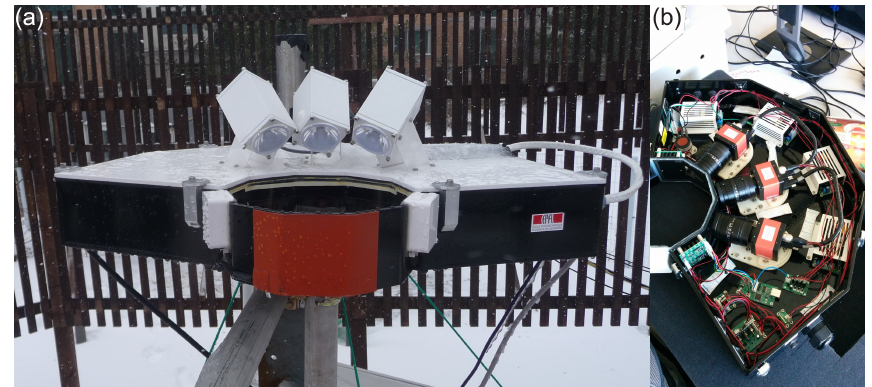
Figure 1. (a) Side view of the MASC with the three flash lamps in white on top and the two detectors as white boxes on the side of the metal ring (in black and red in front). (b) Top view of the inside of the MASC, with the three cameras clearly